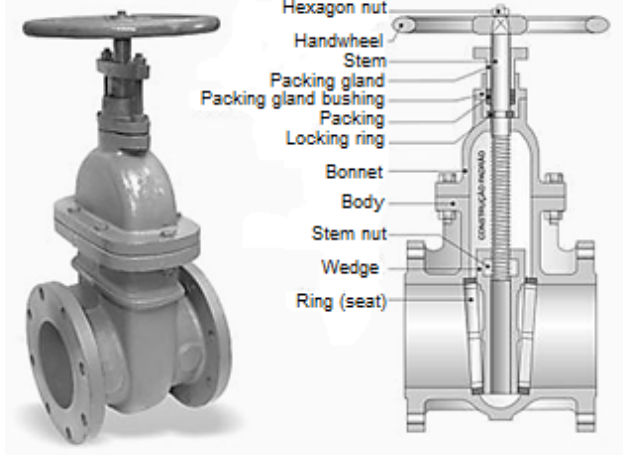
Figure 1. Gate valve [4].